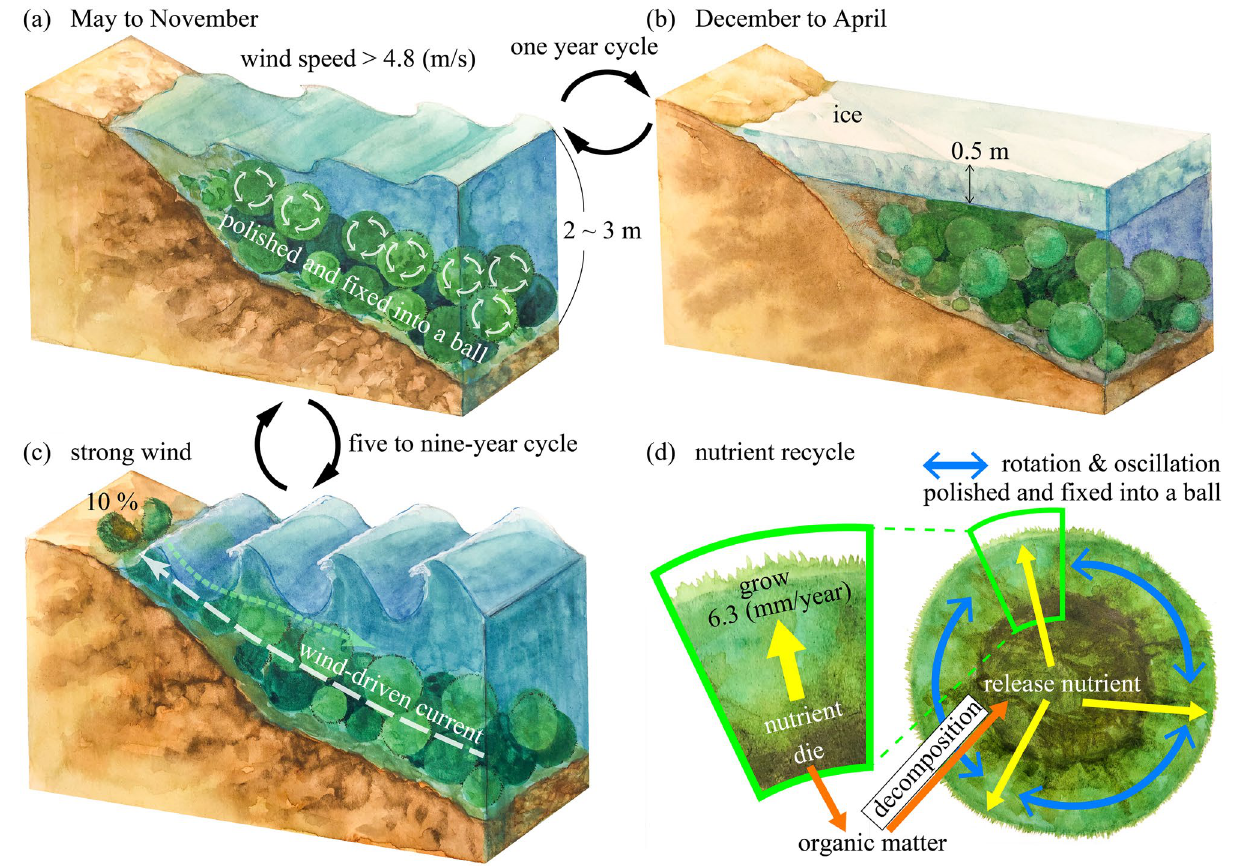
Figure 5. Formation of giant Marimo. ( a ) Growth period: June to October. ( b ) Hibernation period: November to May. ( c ) Marimo are washed ashore due to strong wind, and a small-size Marimo goes back to the Marimo colony. ( d ) Nutrient recycling in Marimo. Illustration adapted with permission from Reina